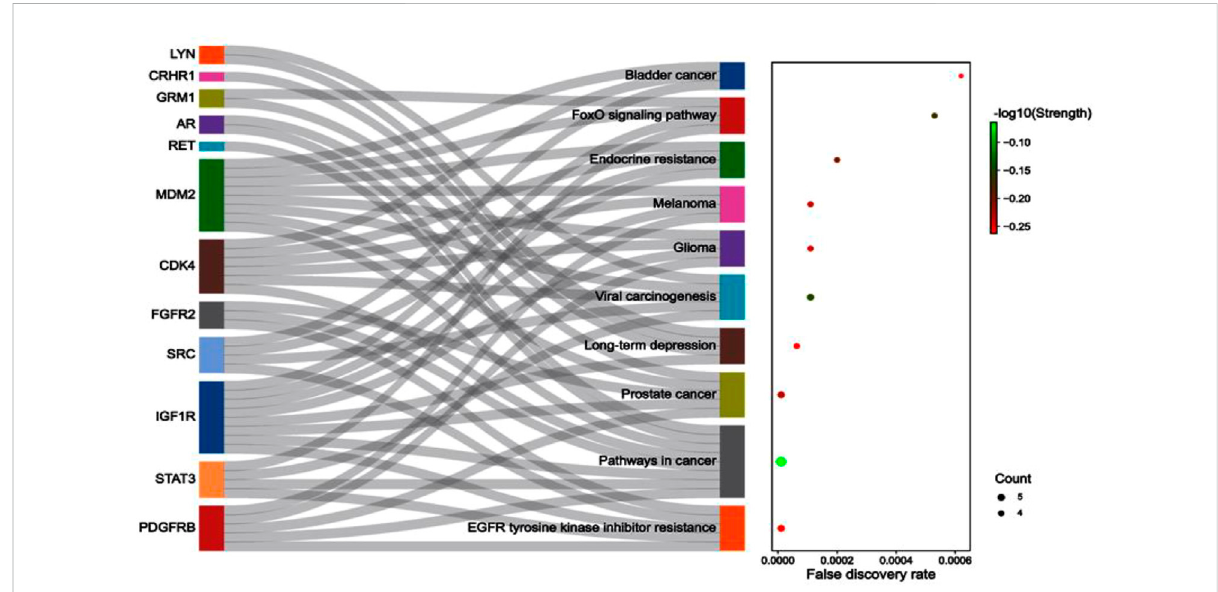
FIGURE 4 The associated protein-pathways interaction with respective false discovery rate and